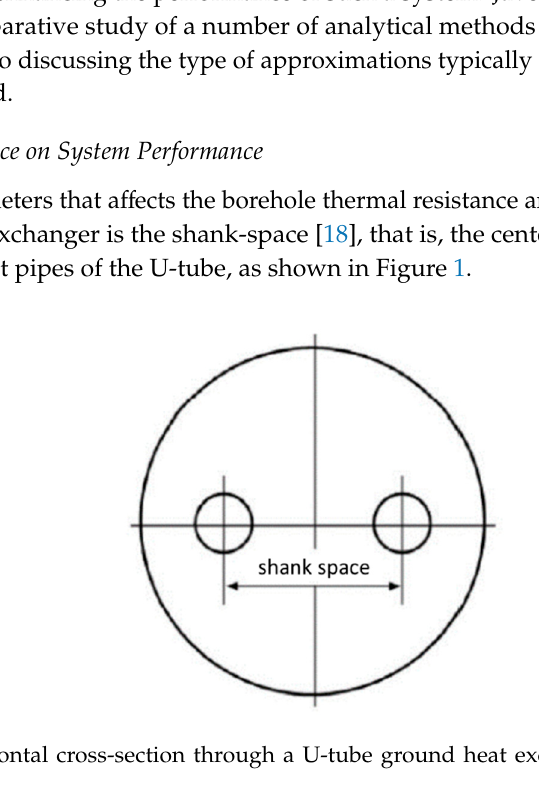
Figure 1. A horizontal cross-section through a U-tube ground heat exchanger (GHE) illustrating the